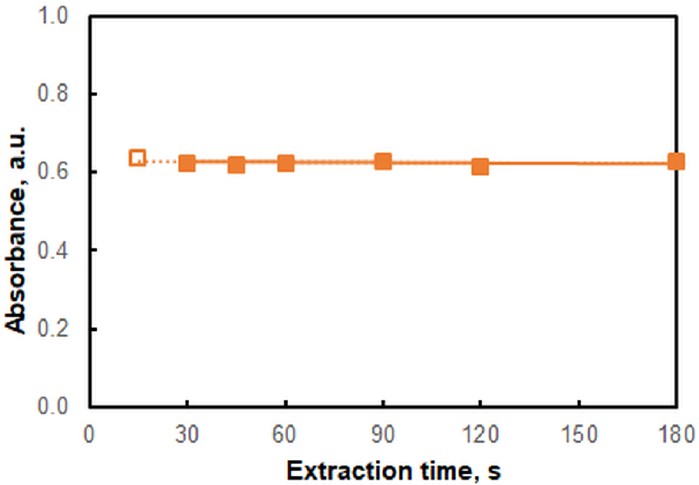
Figure 4. Effect of extraction time; 3 × 10 −5 mol L −1 of V(V), 2.4 × 10 −4 mol L −1 of HTAR, 1.7 × 10 −5 mol L −1 of HZH, pH of 4.3 (ammonium acetate buffer), λ = 554 nm. The empty marker on the left indicates a slow phase separation process.